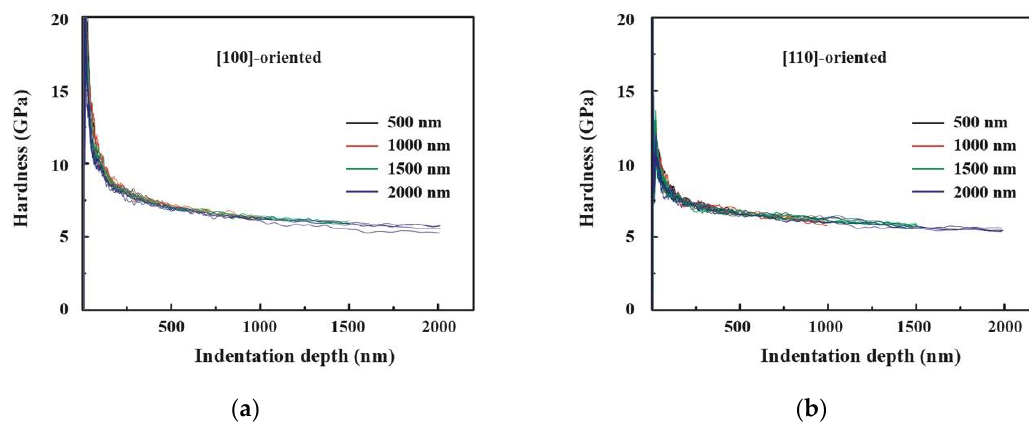
Figure 5. Hardness–indentation depth curves of the ( a ) [100]- and ( b ) [110]-oriented PIN–PMN–PT single crystals at the maximum indentation depths from 500 nm to 2000 nm.